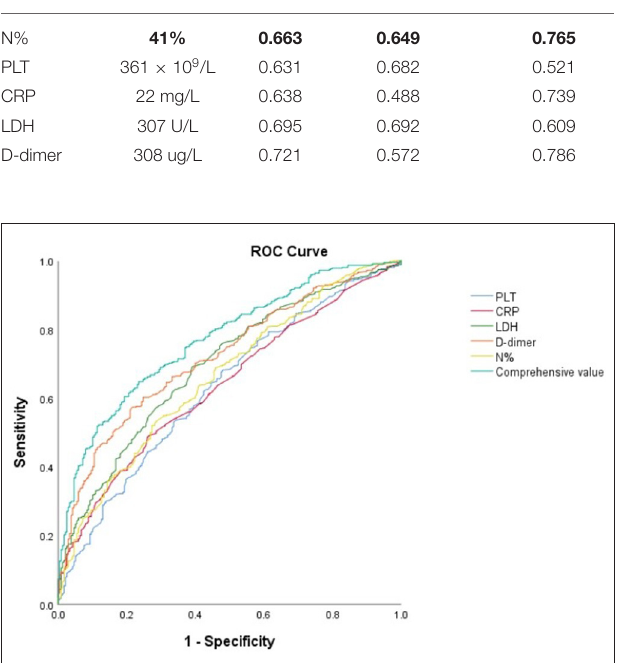
FIGURE 1 | ROC curve between SMPP and NSMPP.